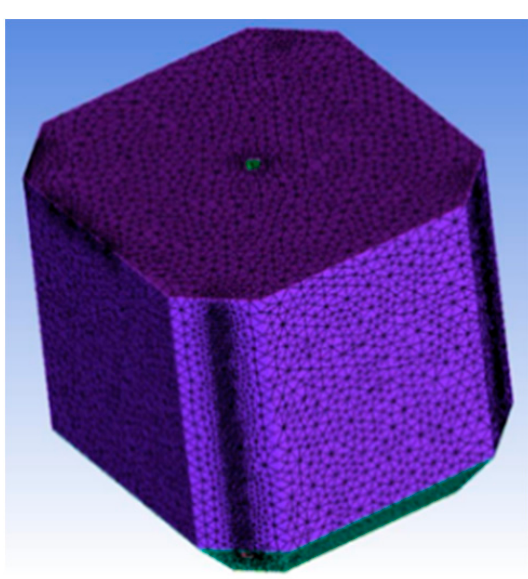
Figure 2. Overall grid distribution diagram. Figure 3. Inlet pipe grid distribution diagram.